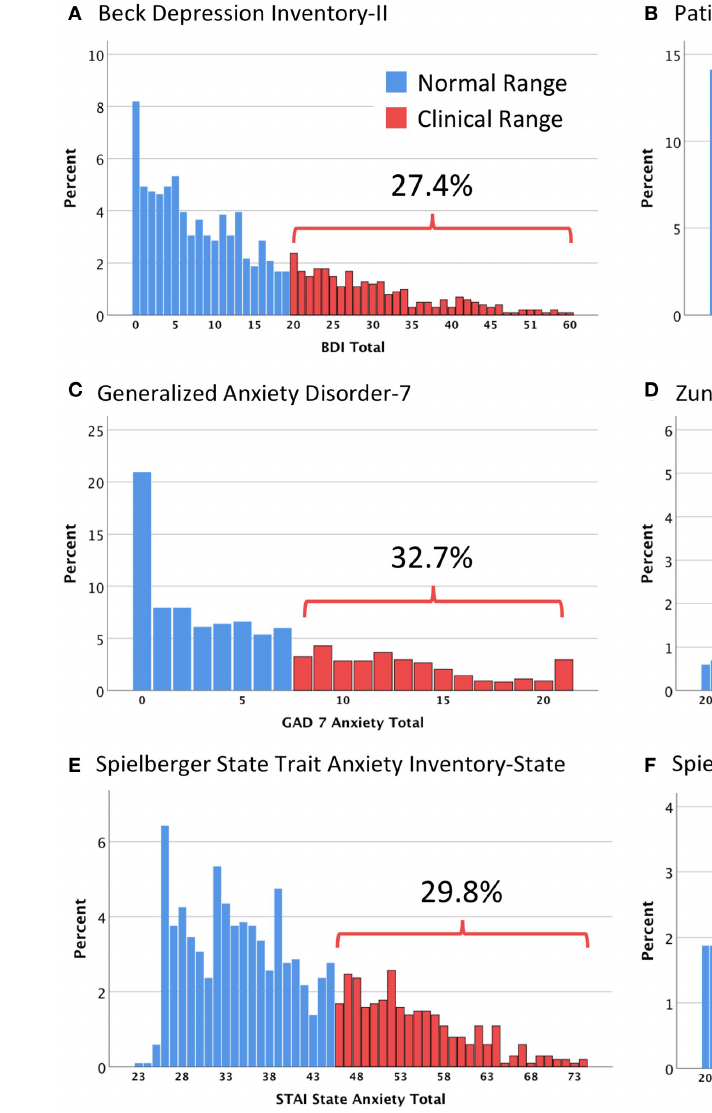
Frontiers in Psychiatry |